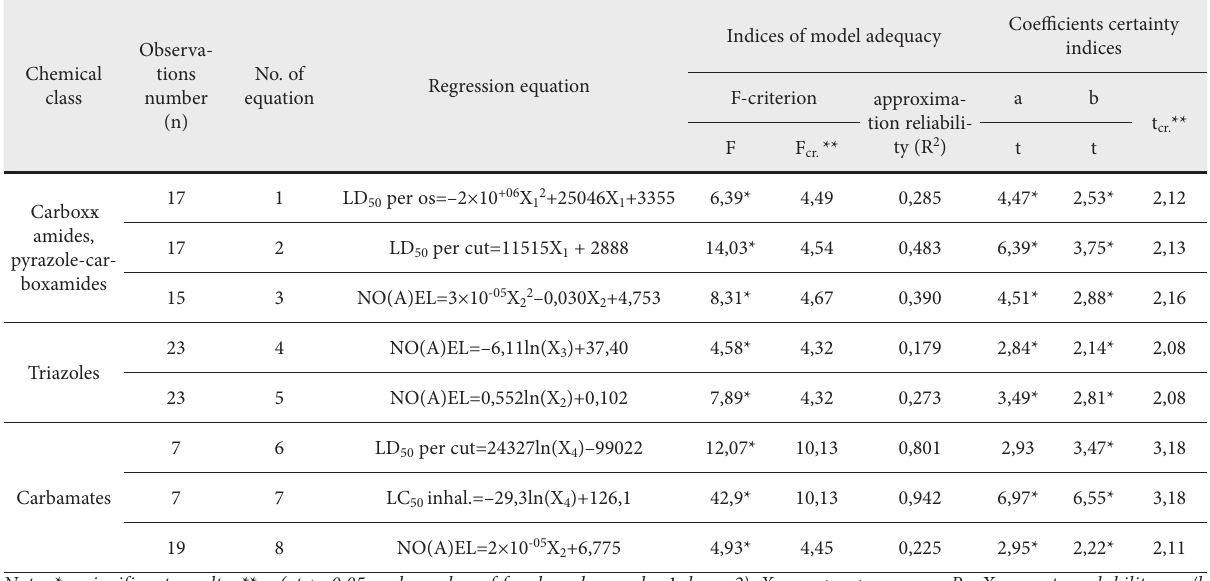
Models of toxicological parameters of different classes of fungicides prediction (linear regression equations)